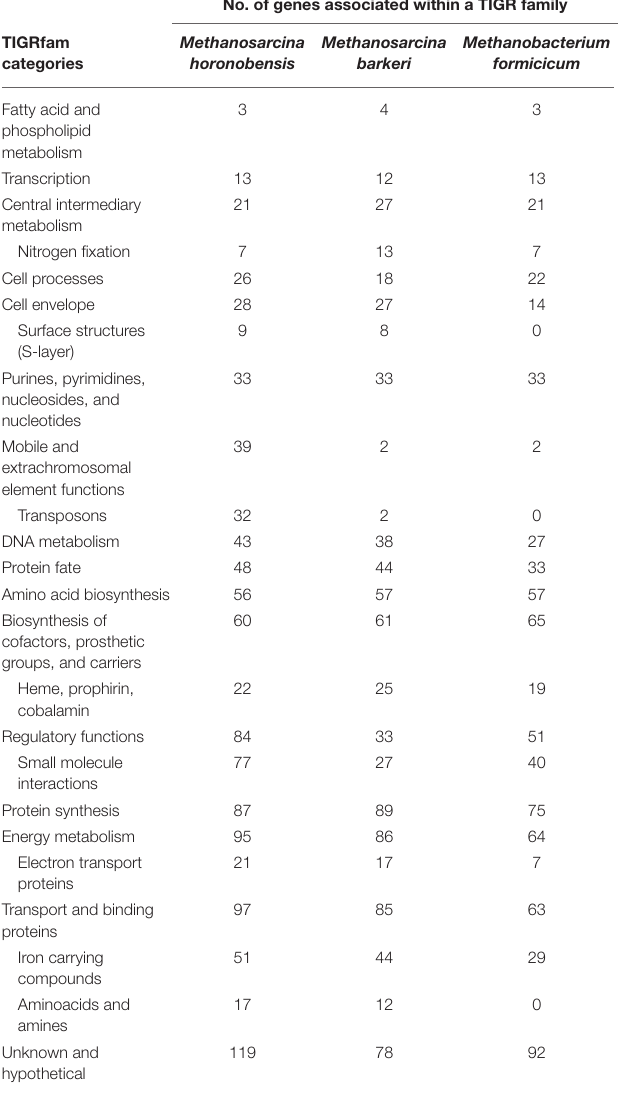
TABLE 2 | Genomic comparison of three methanogens based on TIGR family protein